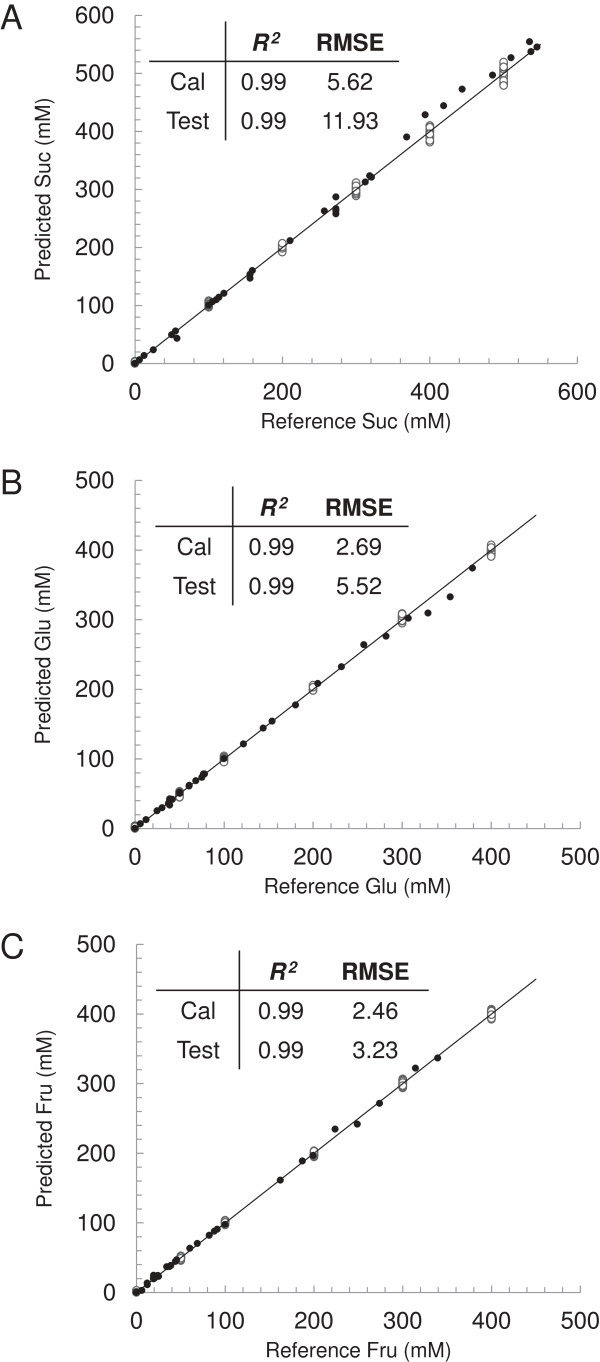
Soluble sugar FTIR PLS prediction models. PLS prediction of (A) sucrose (mM), (B) glucose (mM), and (C) fructose (mM) in an independent test set of S. bicolor juice mixtures. Predictions are plotted against the known reference values for each sample. Calibration samples (○) and independent validation samples (•) were overlaid on a target line (y = x). The coefficient of determination (R2) and root mean square error (RMSE) for each sample set are displayed for each sugar. FTIR, Fourier transform infrared; PLS, partial least squares; RMSE, root mean squared error.